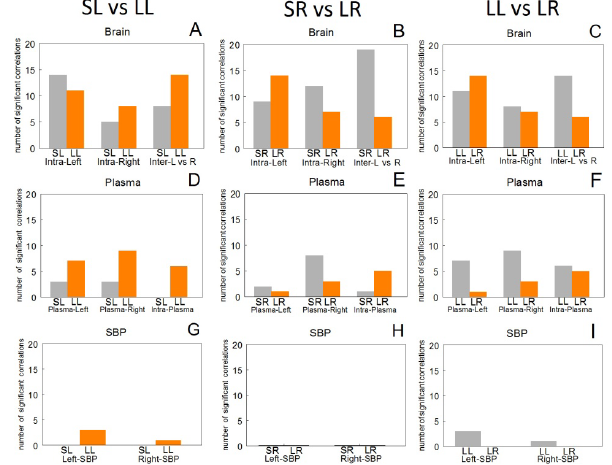
Figure 4. Total number of intra- (Intra-Left or Intra-Right) and inter-hemispheric (Inter-Left vs. Right) significant correlations between brain aminopeptidase activities (Brain) ( A – C ); between plasma aminopeptidase activities versus left (Plasma-Left) or right (Plasma-Right) brain aminopeptidase activities and Intra-Plasma aminopeptidase activities between themselves (Plasma) ( D – F ); between left (Left-SBP) or right (Right-SBP) aminopeptidase activities versus systolic blood pressure (SBP) in Sham Left (SL), Sham Right (SR), Lesioned Left (LL) or Lesioned Right (LR) spontaneously hypertensive rats ( G – I ).